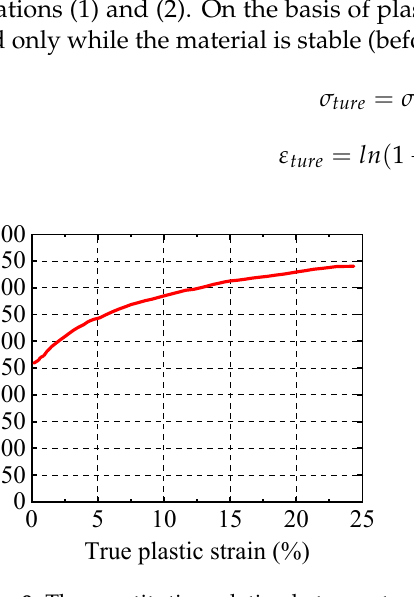
Figure 9. The constitutive relation between true stress and true plastic strain.